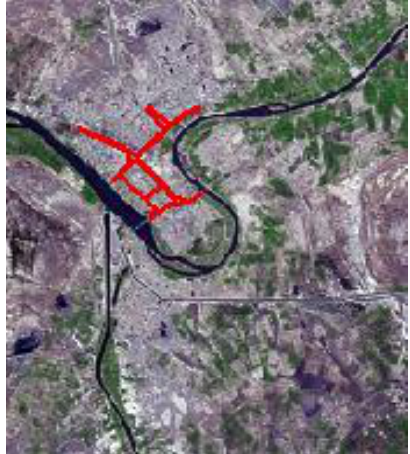
Fig.15: Presented the network for low resolution image with 1:250,000